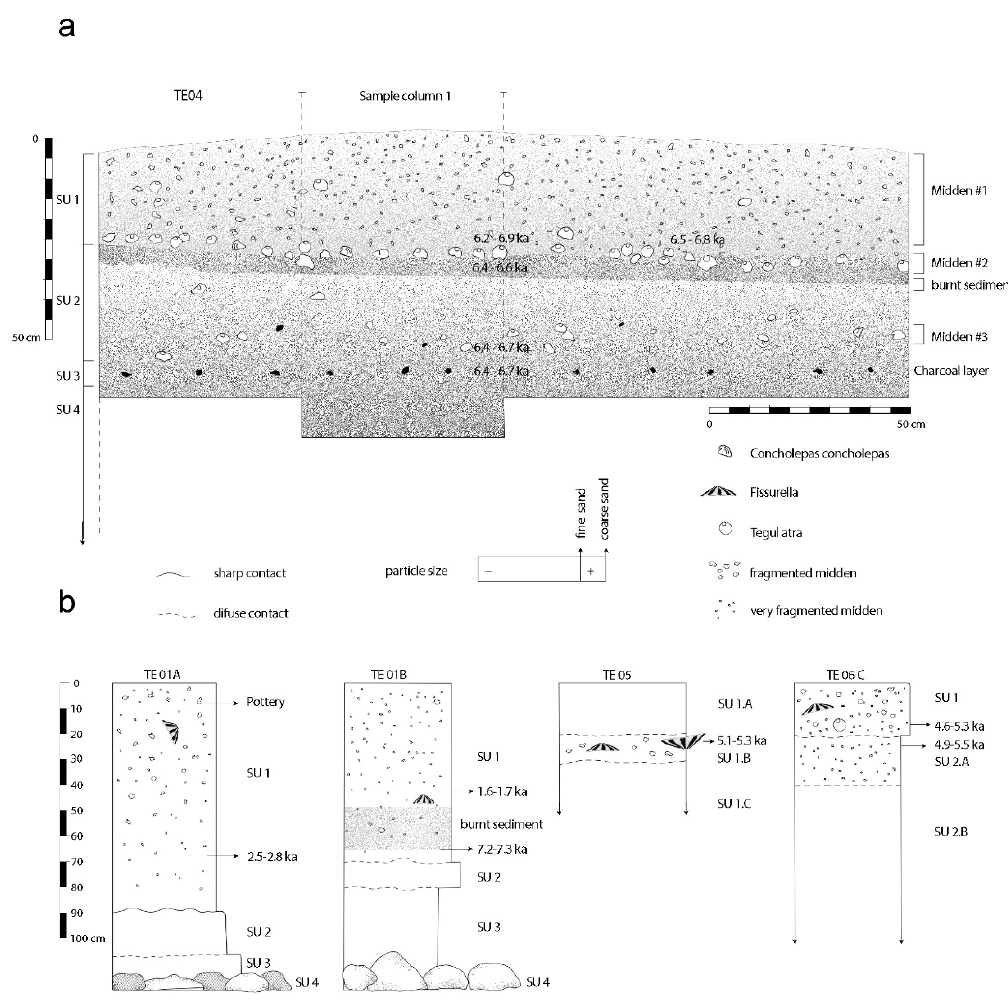
Figure 4. Stratigraphic sections of the sites in El Teniente Bay: ( a ) northeast profile of Las Corvinas 1 (TE04); ( b ) schematic profiles of La Cebada (TE01A, TE01B), Las Corvinas 2 (TE05) and Quebrada San Pedro Norte (TE06C). SU: stratigraphic unit; ka: thousands of years before the present.